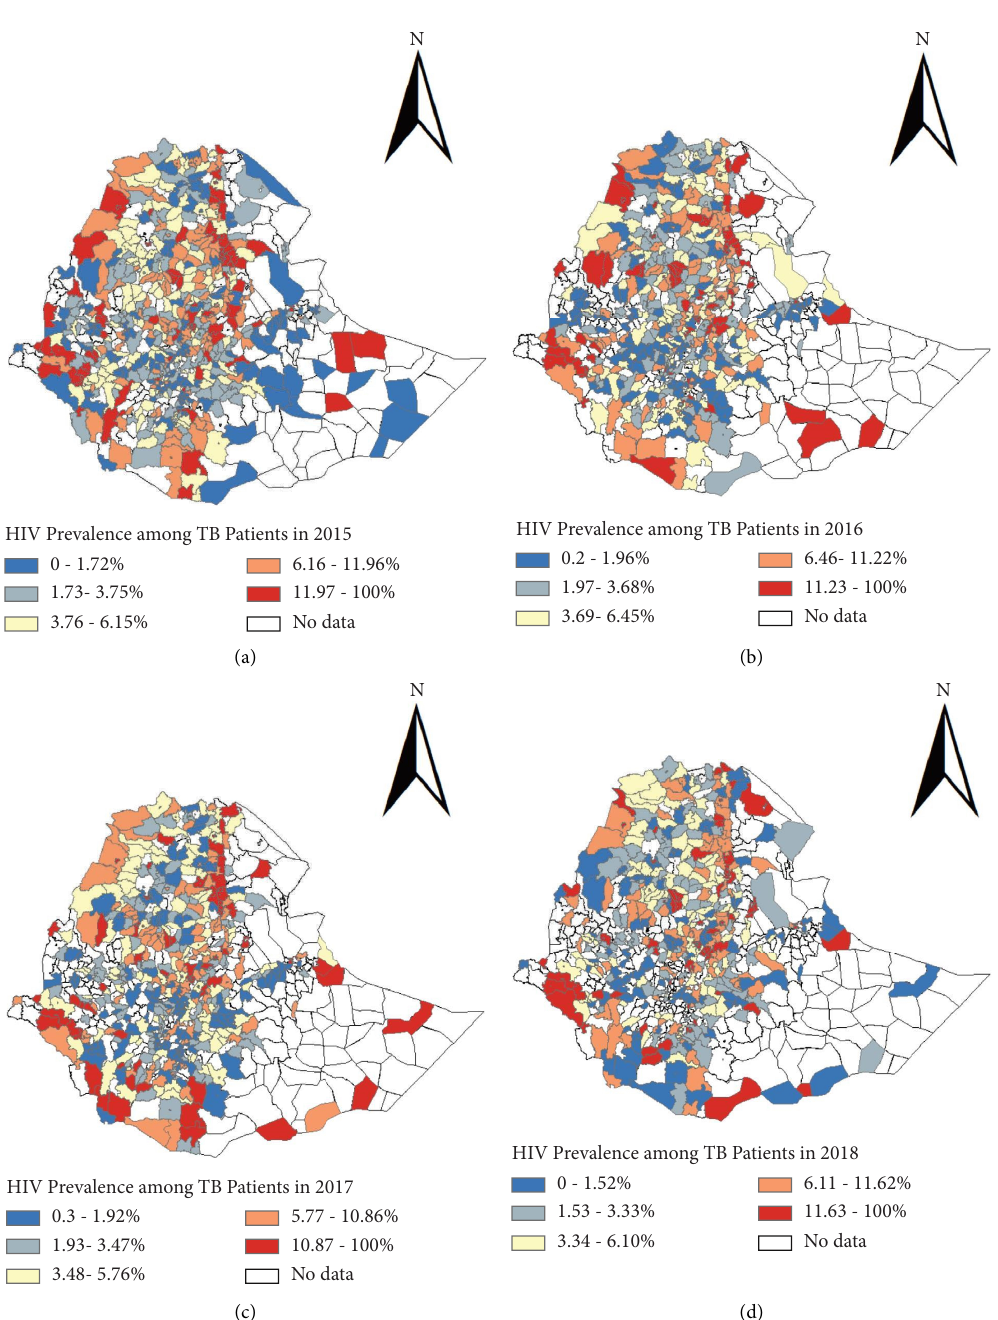
Figure 2: Geographical distribution of the prevalence of HIV among tuberculosis patients in Ethiopia in (a) 2015, (b) 2016, (c) 2017, and (d)